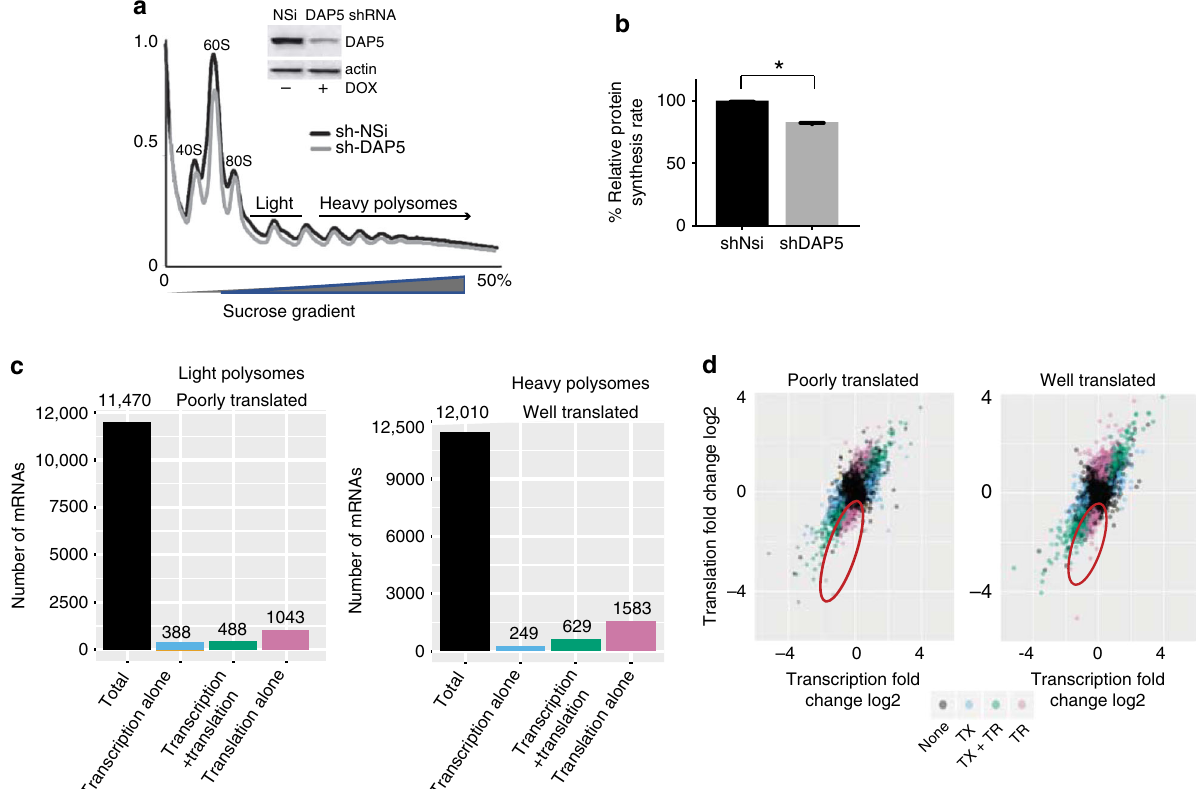
Fig. 1 Genome-wide transcriptiomic and translatomic analysis of DAP5 dependence. a Ribosome absorbance pro fi les obtained from sucrose density gradient analysis of MDA-MB-231 cell lysates without and with DAP5 silencing by Dox-inducible TRIPZ RFP shRNA lentivirus vectors. Light (poorly translated) and heavy (well translated) polysomes and ribosome subunits (40S, 60S, and 80S) are indicated. DAP5 silencing MDA-MB-231 cells was con fi rmed by immunoblot (inset). b Relative protein synthesis rates determined by SUnSET assay-Puromycin incorporation. Puromycin incorporation signals were normalized to loading controls, quanti fi ed, and expressed as percent relative protein synthesis rates ( n = 3). For source data and controls see Supplementary Fig. 2. * P < 0.05 by paired t -test. c Histogram representation of number of mRNAs out of total mRNAs altered in all three treatment conditions for transcription, transcription + translation, or translation alone (translation ef fi ciency). d Total mRNA and puri fi ed mRNA from poorly